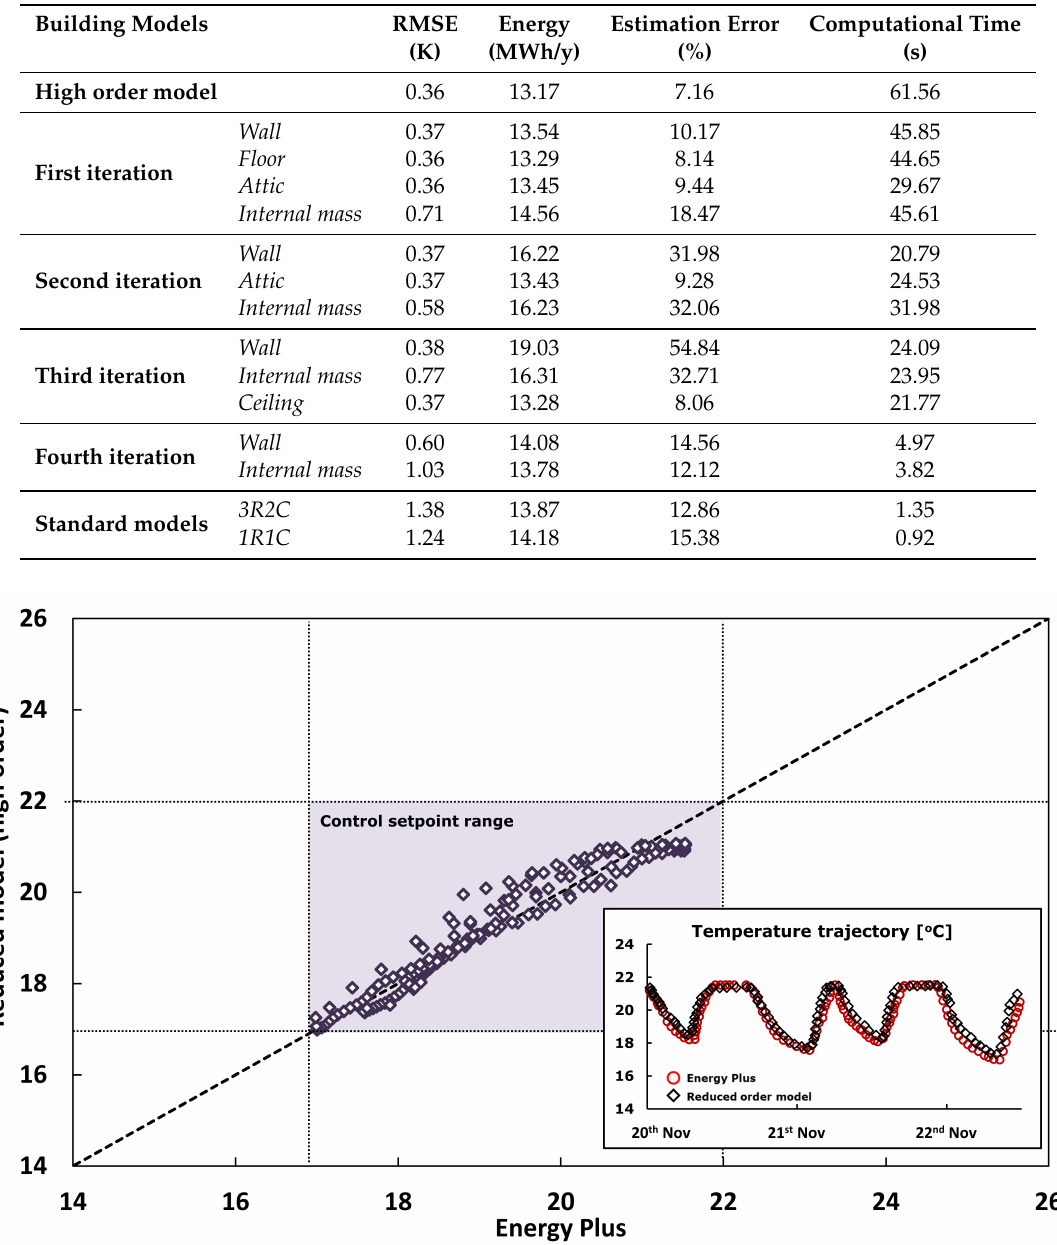
Table 3. Performance metrics and computational time of the different models developed by the reduction methodology.